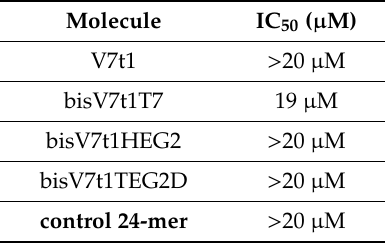
Table 3. IC 50 values of V7t1, its covalent dimers and a control 24-mer on MCF-7 cells after 48 h